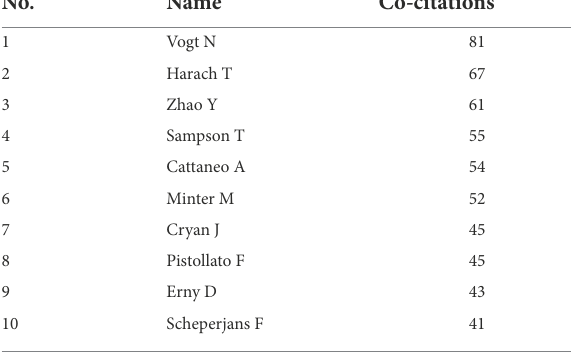
FIGURE 6 Co-cited networks of journals. The size of the nodes in the graph represents the number of publications of the institution, and the thickness of the lines between nodes represents the strength of the relationship. The different colors of nodes and connection lines represent different years (for instance, black represents 2013–2014, and light gray represents 2019–2020).